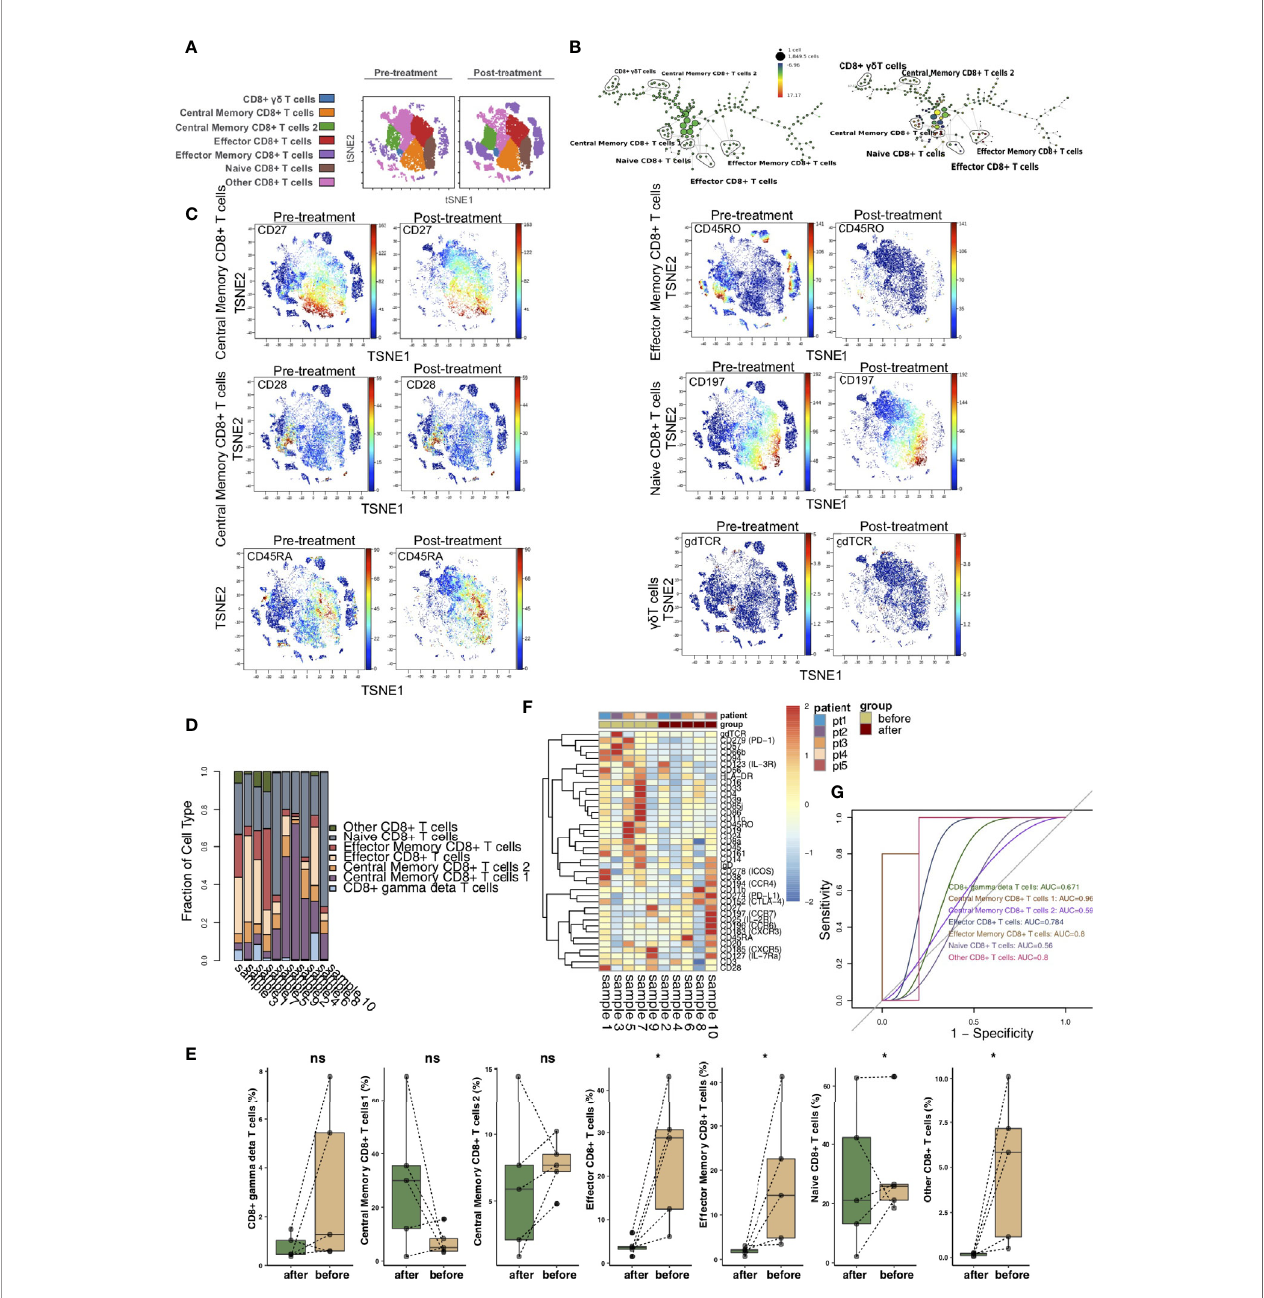
FIGURE 3 | CD8+ T cell subclusters in the kidney. (A) t-SNE plots of CD8+ gd T cells, central memory CD8+ T cells 1, central memory CD8+ T cells 2, naive CD8+ T cells, effector CD8+ T cells, effector memory CD8+ T cells and other CD8+ T cells. (B) In SPADE trees, node color is scaled to the fold change in CD197 (CCR7) content, and node size is scaled to the number of cells. (C) t-SNE plots of gdTCR, CD27, CCR7, CD28, CD45RA and CD45RO expression in the pre- and posttreatment groups. (D) The proportions of CD8+ T cell subclusters in all samples. (E) Comparison of the proportions of CD8+ T cell subclusters between the pre- and posttreatment groups. (F) Heatmap of the marker expression of CD8+ T cells for all samples. (G) ROC curve of CD8+ T cell subclusters predicting the pre- and posttreatment groups. *P < 0.05; ns, not signi fi